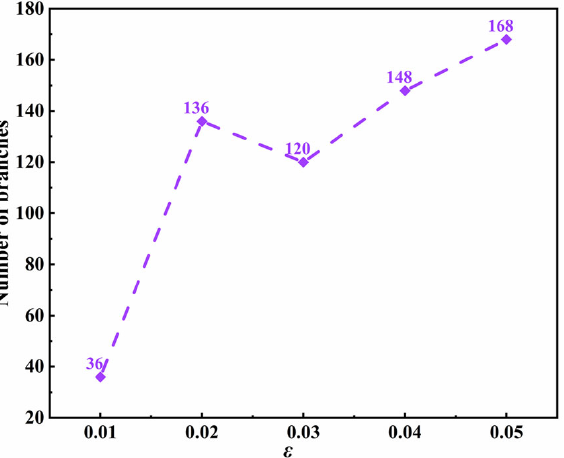
Figure 4. The relationship between the number of branches of a PTFE crystal and anisotropic strength (anisotropic mode j = 6, evolution of time τ = 160).